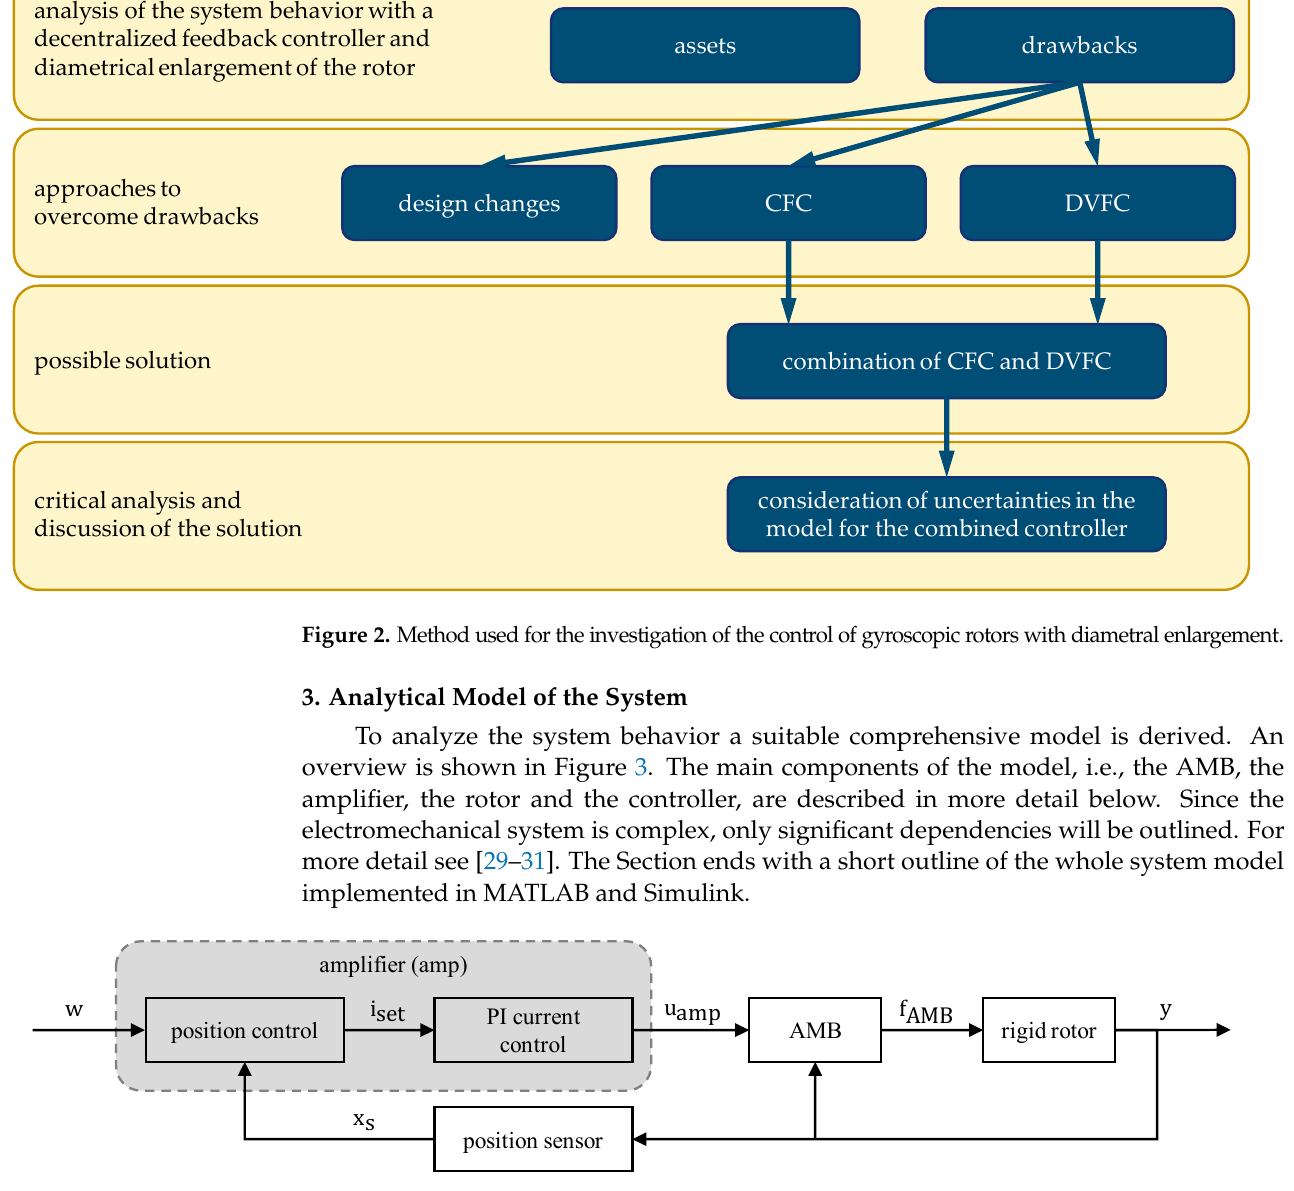
Figure 3. Overview of the derived model.